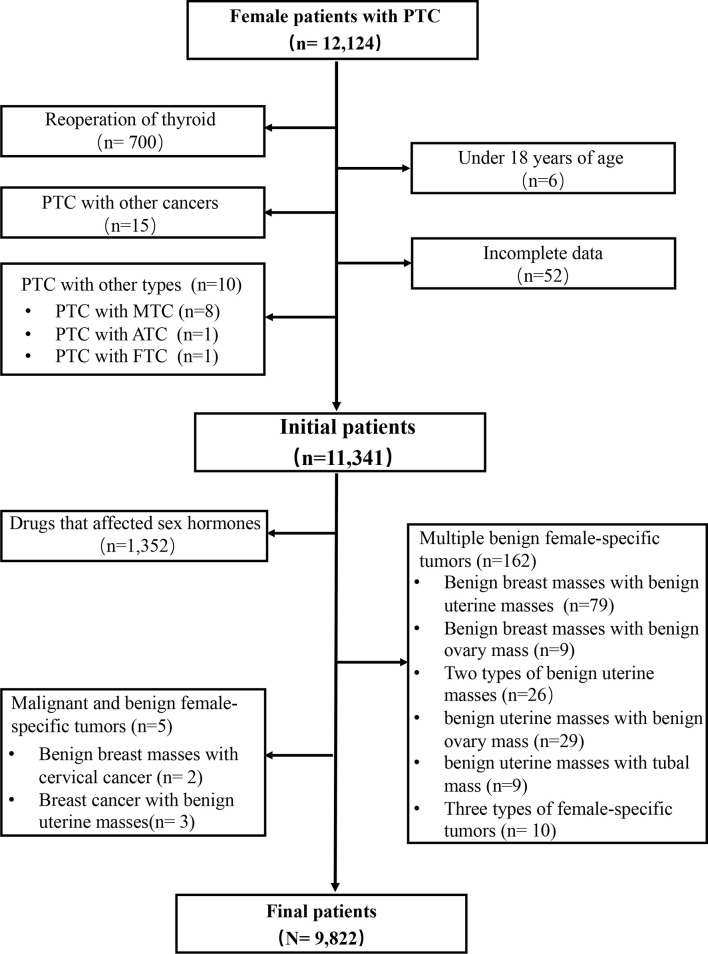
Flow chart of patient selection.